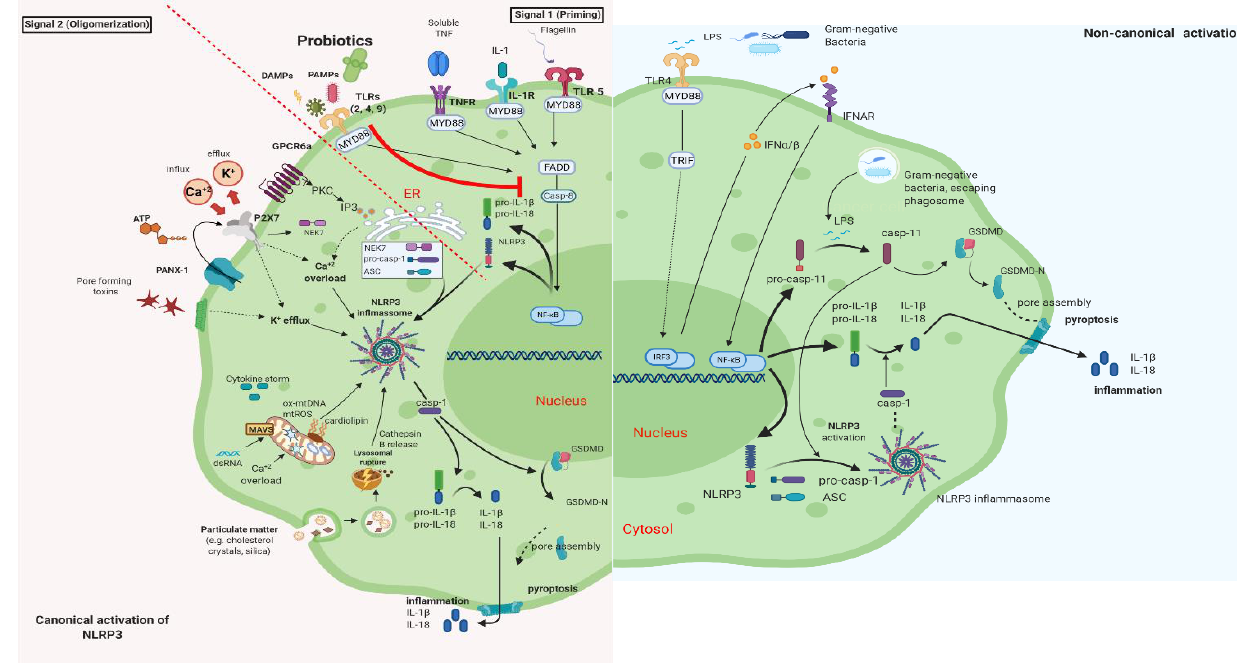
Figure 2. Canonical and Non-Canonical activation of NLRP3 inflammasome. The macrophage in an animal model (transgenic mice-expressing the human angiotensin I-converting enzyme 2 (ACE2) receptor driven by the cytokeratin-18 (K18) gene promoter (K18-hACE2)) [21,22]. (i) The canonical pathway of NLRP3 requires a two-step process: priming and activation. Priming (signal 1) is the upregulation of the NLRP3 inflammasome components, NLRP3, pro-IL β , and pro- caspase. This transcriptional upregulation is stimulated by PAMPs (bacterial, fungal, viral) or DAMPs which are recognized by PRRs such as TLRs. Additionally, cytokines such as TNF or IL-1 stimulate this upregulation by engaging TNFR and IL1-R, respectively. The activation (signal 2) is provided by various stress signals such as ion or plasma perturbations, ATP, lysosomal rupture, particulate matter, mitochondrial antiviral-signaling protein, mitochondrial reactive oxygen species, ox-mtDNA, etc. Oligomerization of NLRP3 inflammasome activates caspase-1, which in turn cleaves pro-IL β , pro-IL18, and GSDMD and induces pyroptosis and inflammation [23]. (ii) Gram-negative bacteria (e.g., lipopolysaccharide (LPS) or outer membrane vesicle from bacteria) can activate the non-canonical inflammasome pathway that involves NLRP3-dependent caspase-4/5 in humans (known as caspase-11 in murine models) [24]. Caspase-11, when it is secreted at normal rates, protects against bacterial infections, but its excessive activation can cause tissue damage and pyroptosis which is activated in both pathways through cytosolic gasdermin (GSDMD), a member of the gasdermin family [25]. GSDMD cleavage generates a N-terminal domain that is capable of forming plasma membrane pores and a C-terminal domain that acts as an inhibitor of cytolysis [26]. The cleaved N-terminal domain of GSDMD oligomerizes and forms pores on the host cell membrane, leading to pyroptosis and further activation of NLRP3 by triggering K + efflux [27,28]. This figure was created with BioRender (https://biorender.com, accessed on 2 October